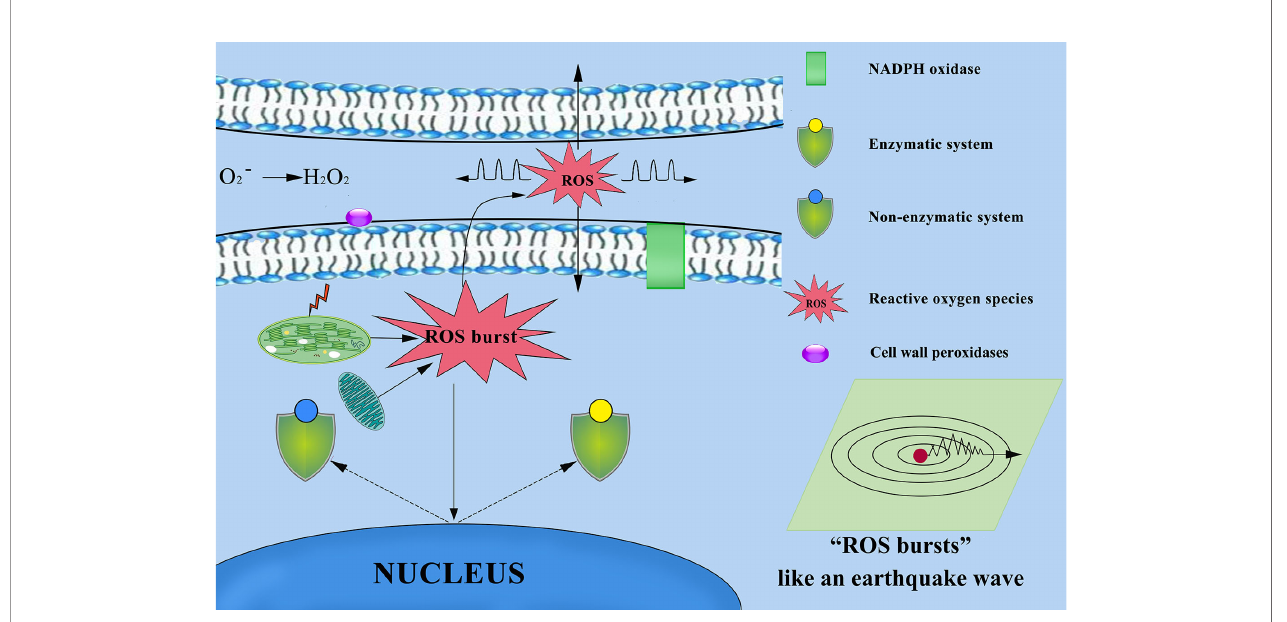
FIGURE 13 | Mechanism of reactive oxygen species (ROS) diffusion in cytoplasmic and other cells. Chloroplasts, mitochondria, cell wall peroxidases, and plasma membrane NADPH oxidases play important roles in ROS production. ROS as highly dynamic signalling molecules that ROS propagate throughout the different tissues and cells, and between different organelles and cells over long distances. When the plant defence system collapses, excessive accumulation of ROS from multiple sources results in ROS bursts that damage other surrounding cells and severely damage cellular